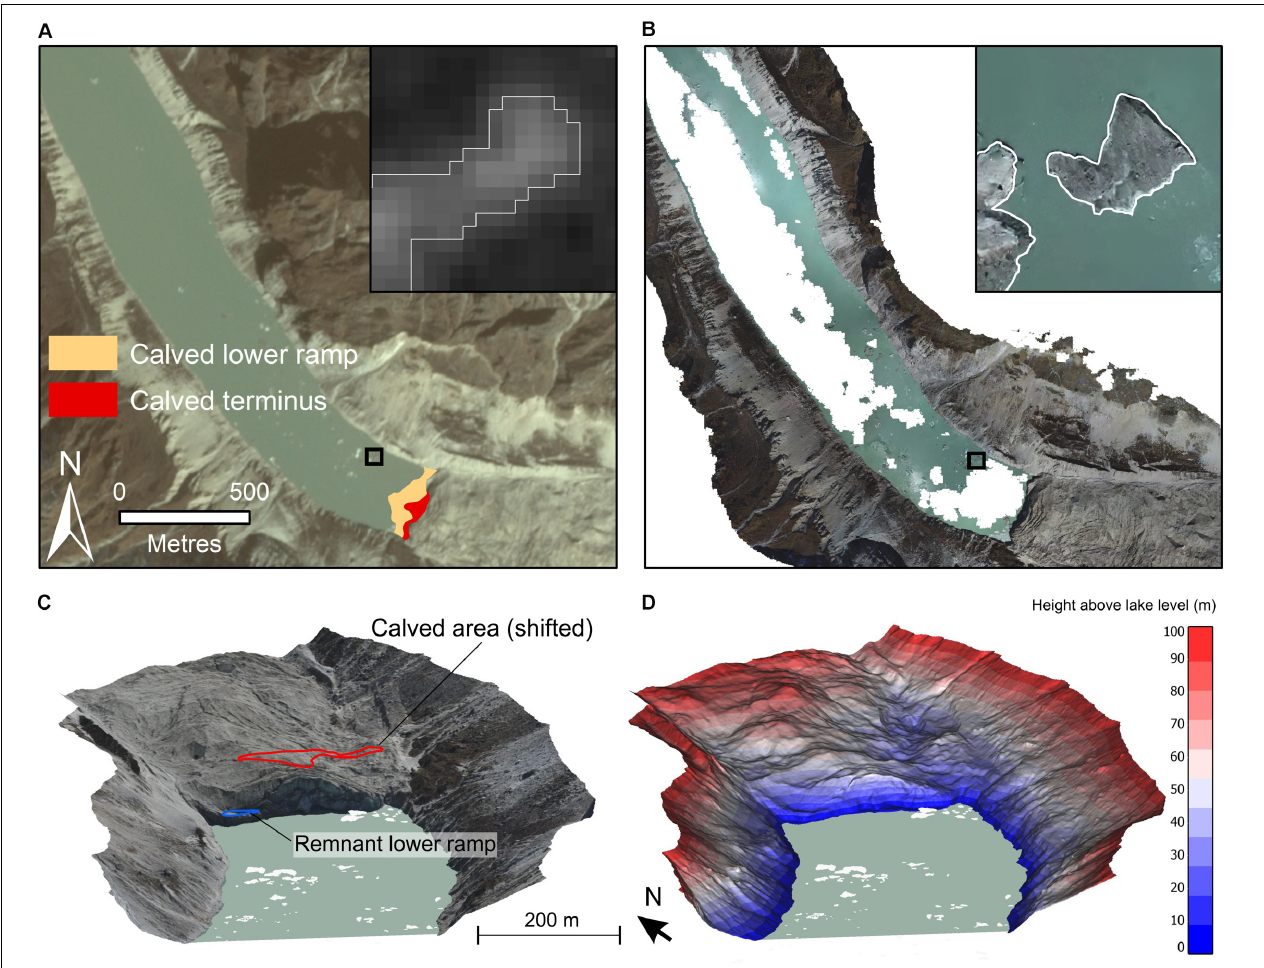
FIGURE 2 | (A) Calved area of Thulagi Glacier shown on a PlanetScope satellite image (27 October 2017). Inset shows iceberg classification (white polygon) on an NDWI image. (B) Orthophoto generated from UAV flights on 27 October 2017. Inset shows the same icebergs as A . (C) Oblique view of the structure-from-motion model showing icebergs (white) and the calved area shifted up-glacier in order to estimate the calving event volume. (D) Height above lake level used to estimate the volume of the calved